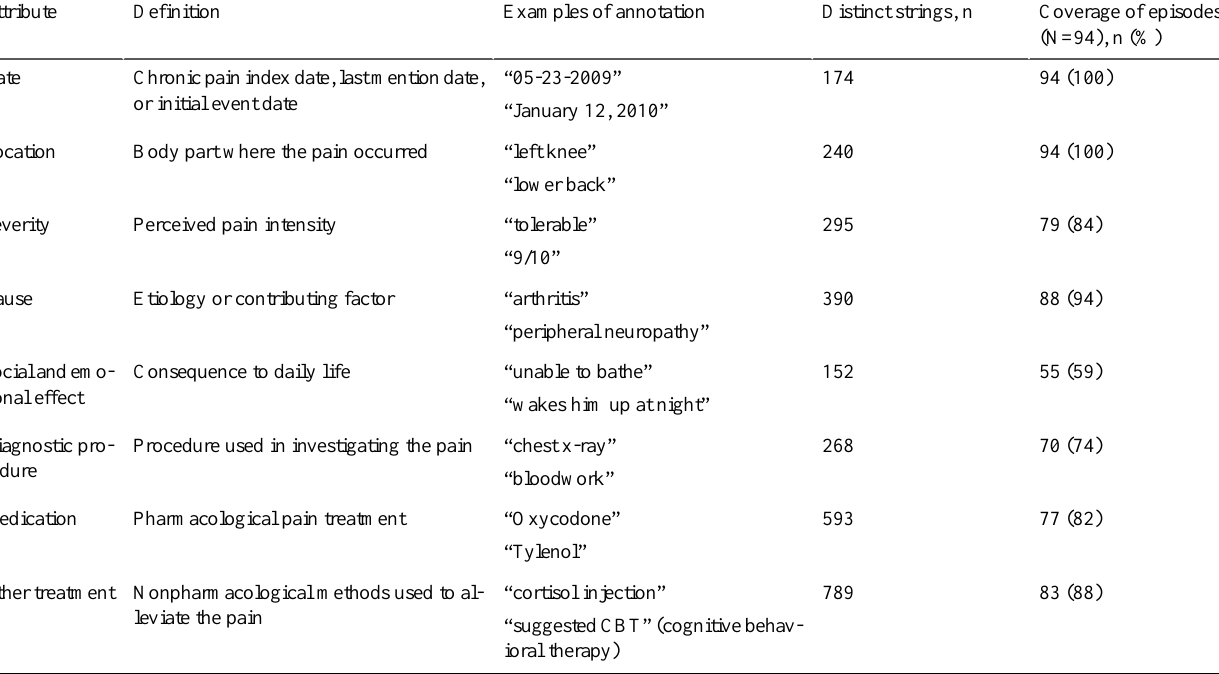
Table 4. Chronic pain attributes, examples, distinct strings, and the frequency of episodes that had the attribute annotated.